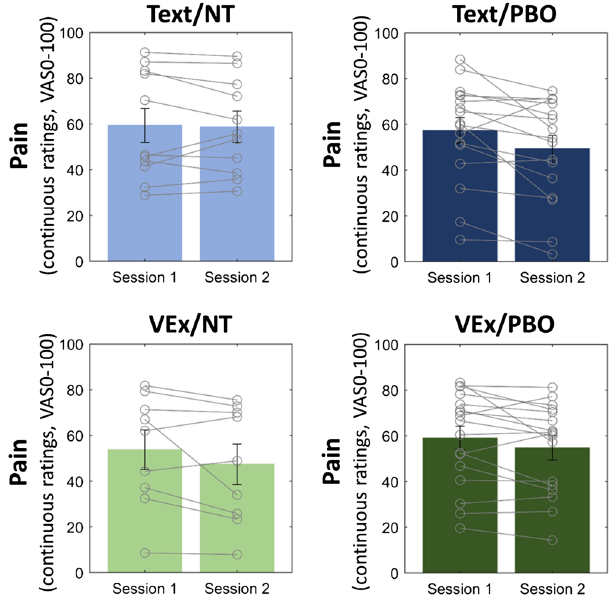
Figure 5. Change in mean pain ratings between session 1 and 2, by experimental condition